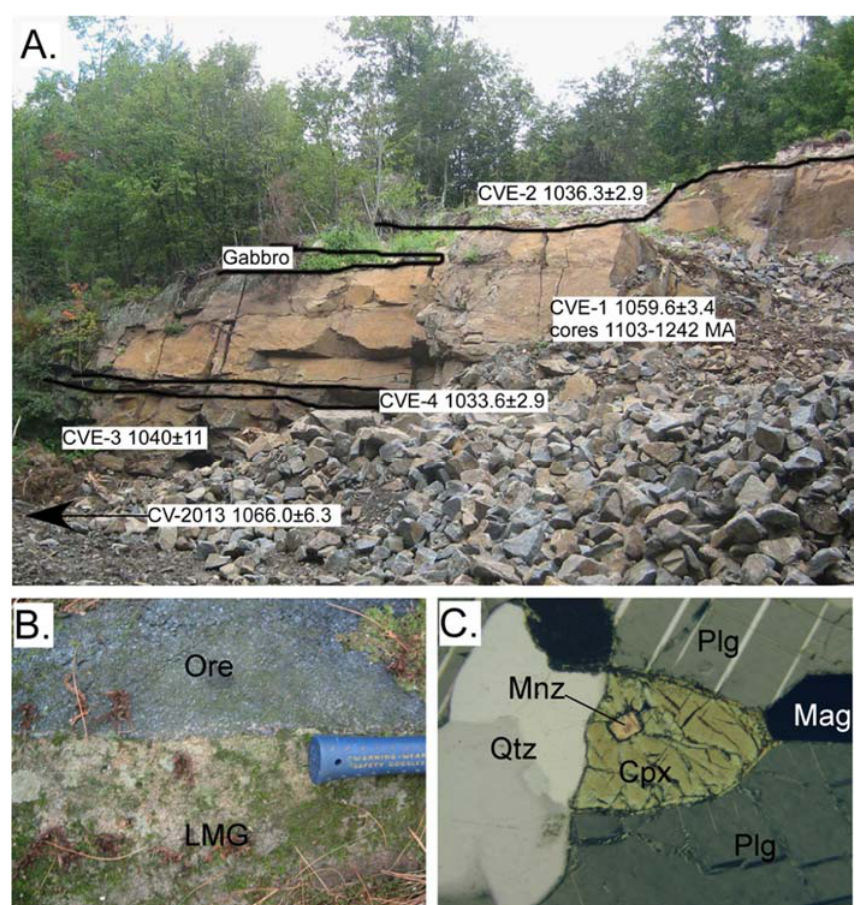
Figure 4. Geologic map of the area surrounding the Cheever Mine near Port Henry, NY. Satellite imagery from Google Earth.